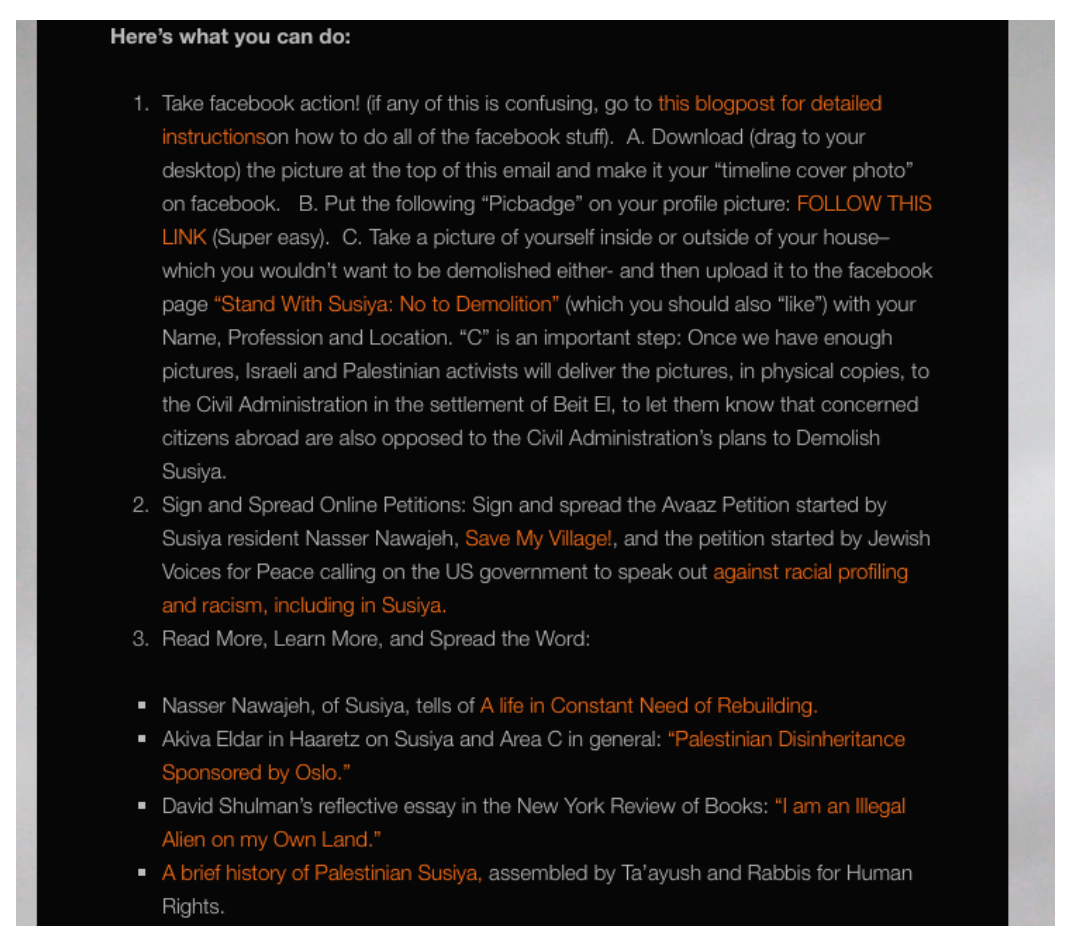
Figure 2. Screen grab from the Susiya Forever WordPress blog outlining how to take online action (Accessed on13 October 2016).